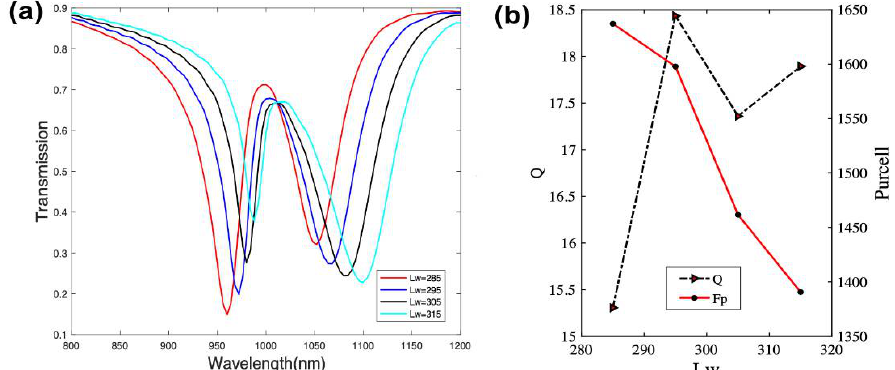
Figure 4. The transmission spectrum ( a ) and Q/Purcell factors ( b ) corresponding to varying (cid:1827) (cid:2870) .